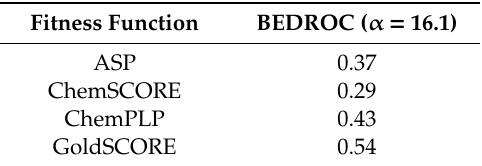
Table 1. Boltzman enhanced discrimination of the ROC curve (BEDROC) values of fitness functions implemented in the GOLD program.